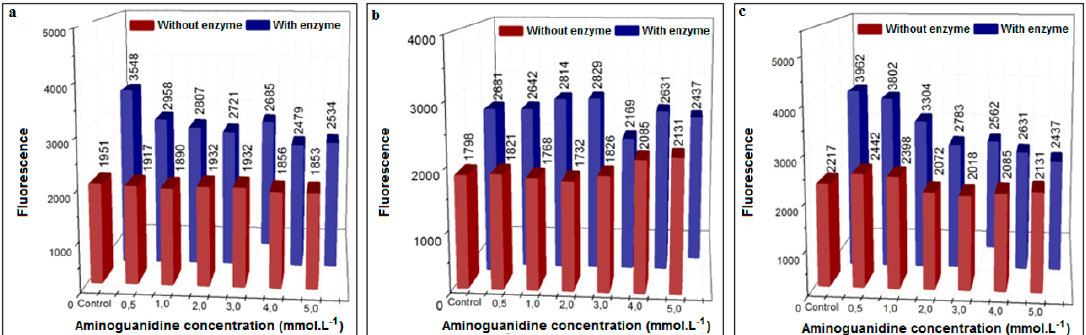
Figure 7. Inhibition of AGEs formation using different concentrations of aminoguanidine (37 °C) in the presence or absence of XO in pure phosphate buffer (pH = 6.6). ( a ) Procedure with glucose, 48 h incubation; ( b ) procedure with MGO, 3 h incubation; ( c ) procedure with GO, 3 h incubation.